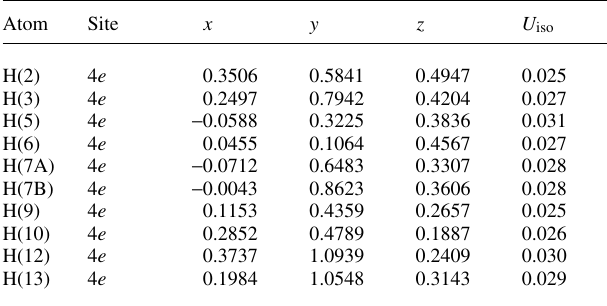
Table 2. Atomic coordinates and displacement parameters (in Å 2 ) .